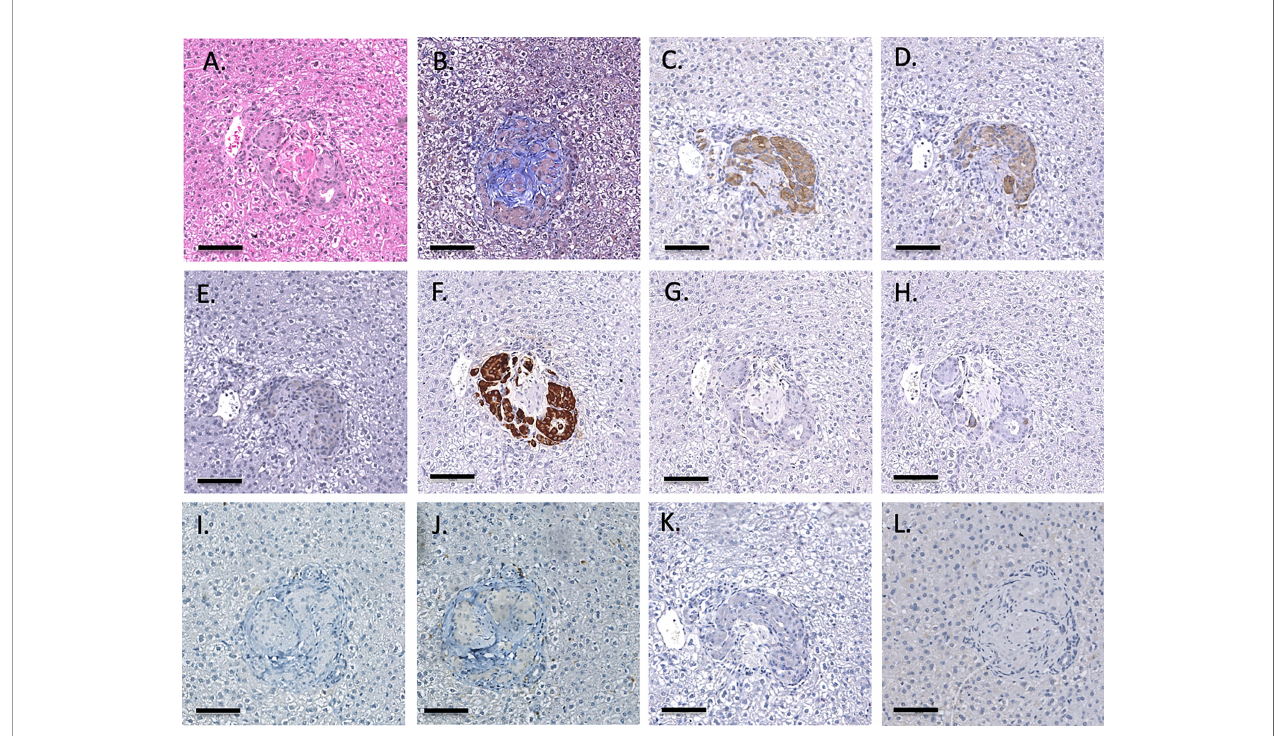
FIGURE 8 | Representative 6-month liver biopsy stained for H&E (A) , MSB (B) , CD55 (C) , CD59 (D) , chromogranin A (E) , insulin (F) , glucagon (G) , somatostatin (H) , CD20 (I) , CD3 (J) , neutrophil elastase (K) and FoxP3 (L) . Magni fi cation X200, indicator bar 100